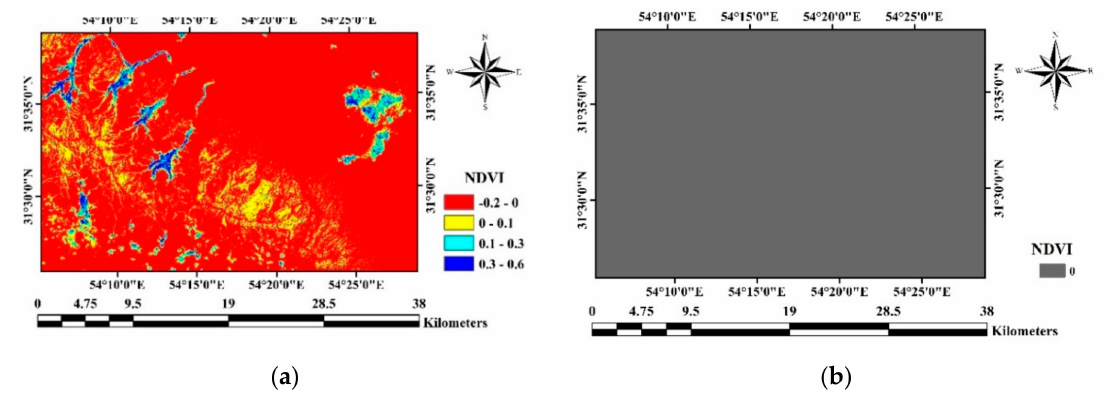
Figure 17. An image extracted from the time series ( a ) and NaN (or zero) value image ( b ).